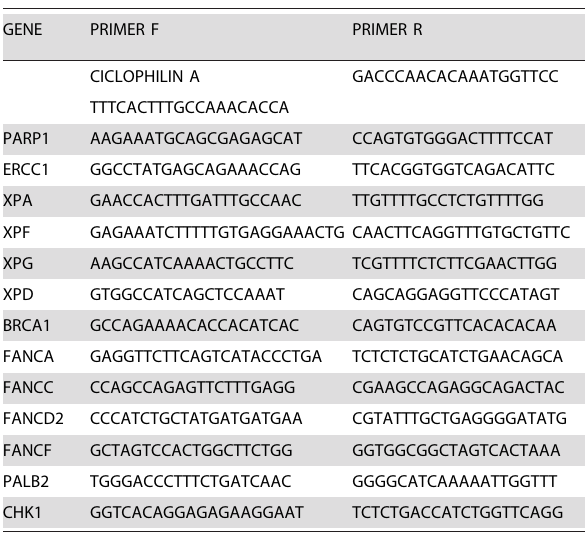
Table 2. Real Time PCR